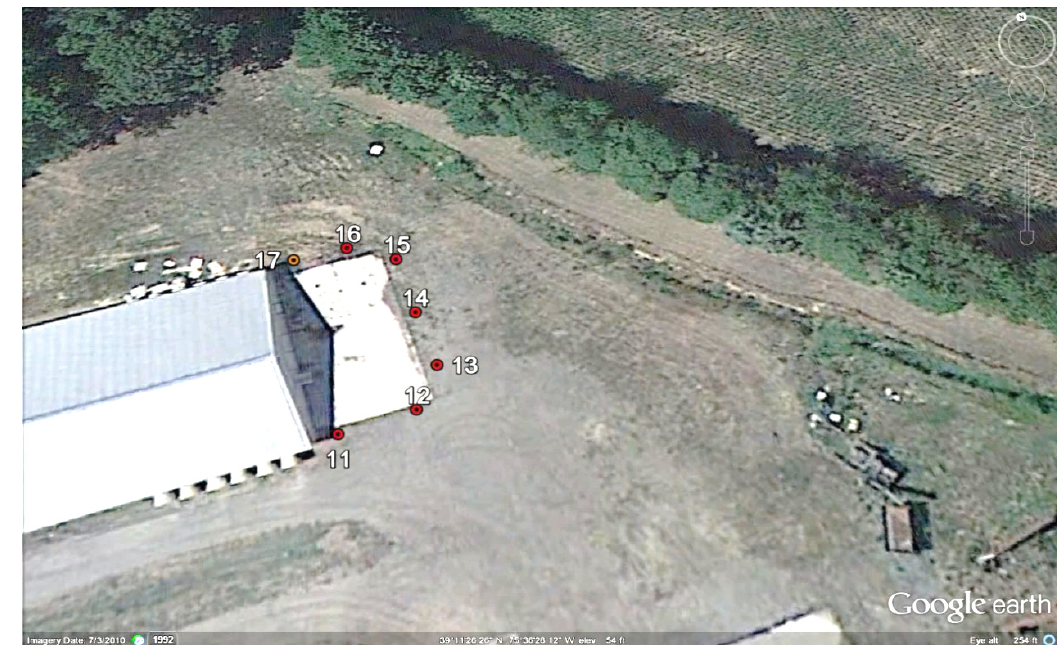
Figure 4. Aerial view showing soil sampling points in the farm—Site II. Numbers in figure denotes sampling locations. Please see table 1 for the specific sites descriptions.